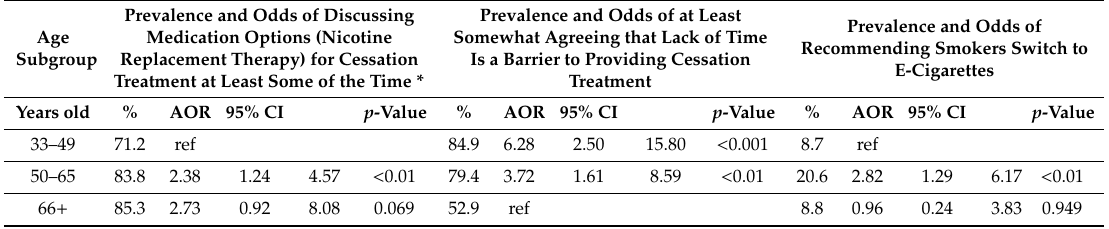
Table 2. Association between age subgroups of ob / gyns, and communication practices and perceptions.